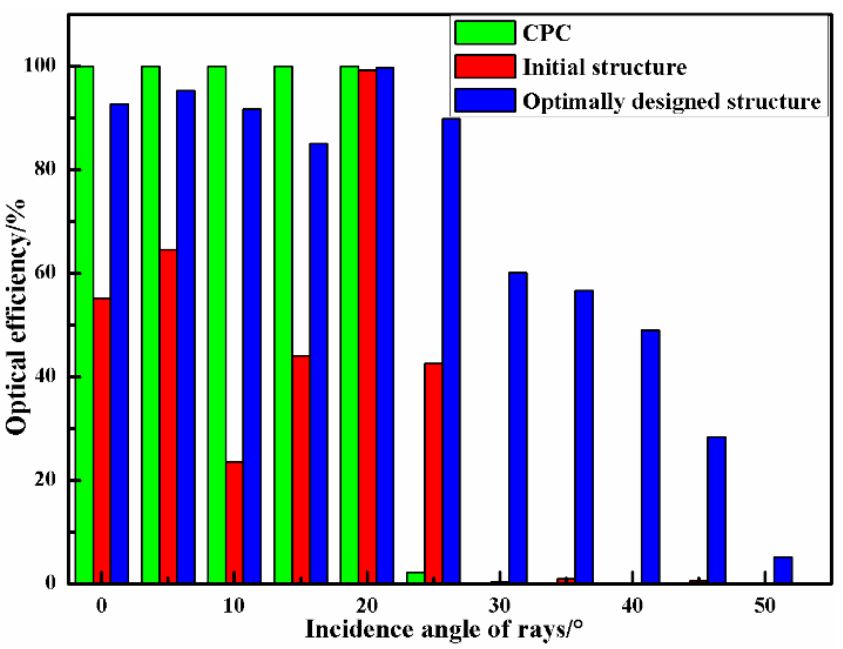
Figure 12. Optical efficiency comparison of the CPC, initial structure, and optimally designed structure for the optical receiver.